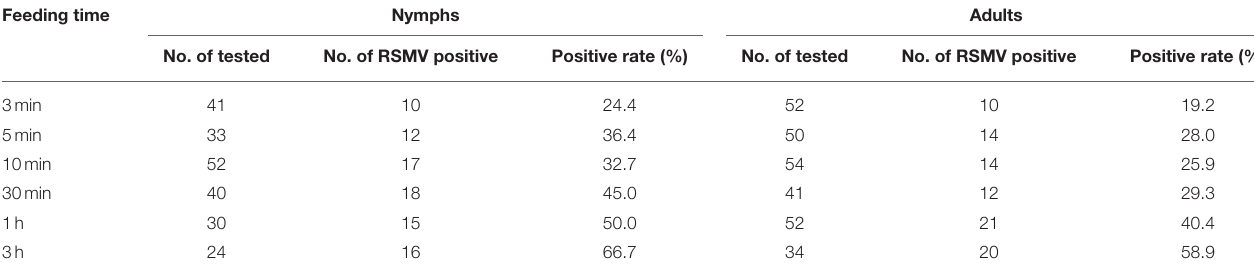
TABLE 1 | The RSMV acquisition rate of Recilia dorsalis when feeding on RSMV-infected rice plants. Feeding time